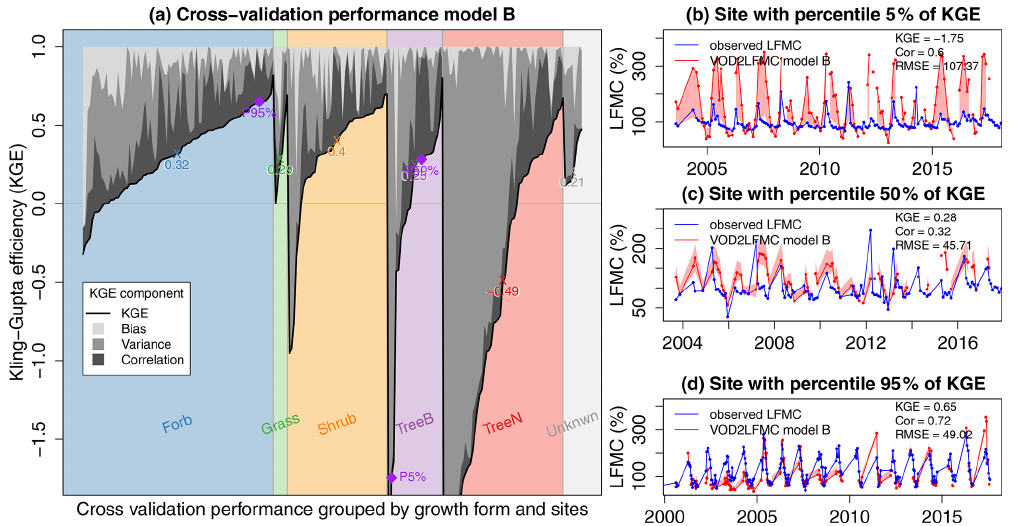
Figure 7. Performance of Model B using Ku-VOD in spatial cross-validation at each site grouped by the sampled vegetation growth form of LFMC measurements. (a) Kling–Gupta efficiency with its components caused by bias, variance, and correlation. Purple dots represent the 5th, 50th, and 95th percentiles of the KGE across all sites. The time series of the sites corresponding to those percentiles are shown in panels ( b , 5% = site with low performance, broad-leaved tree site), ( c , 50% = site with medium performance, broad-leaved tree site), and ( d , 95% = site with good performance, forb